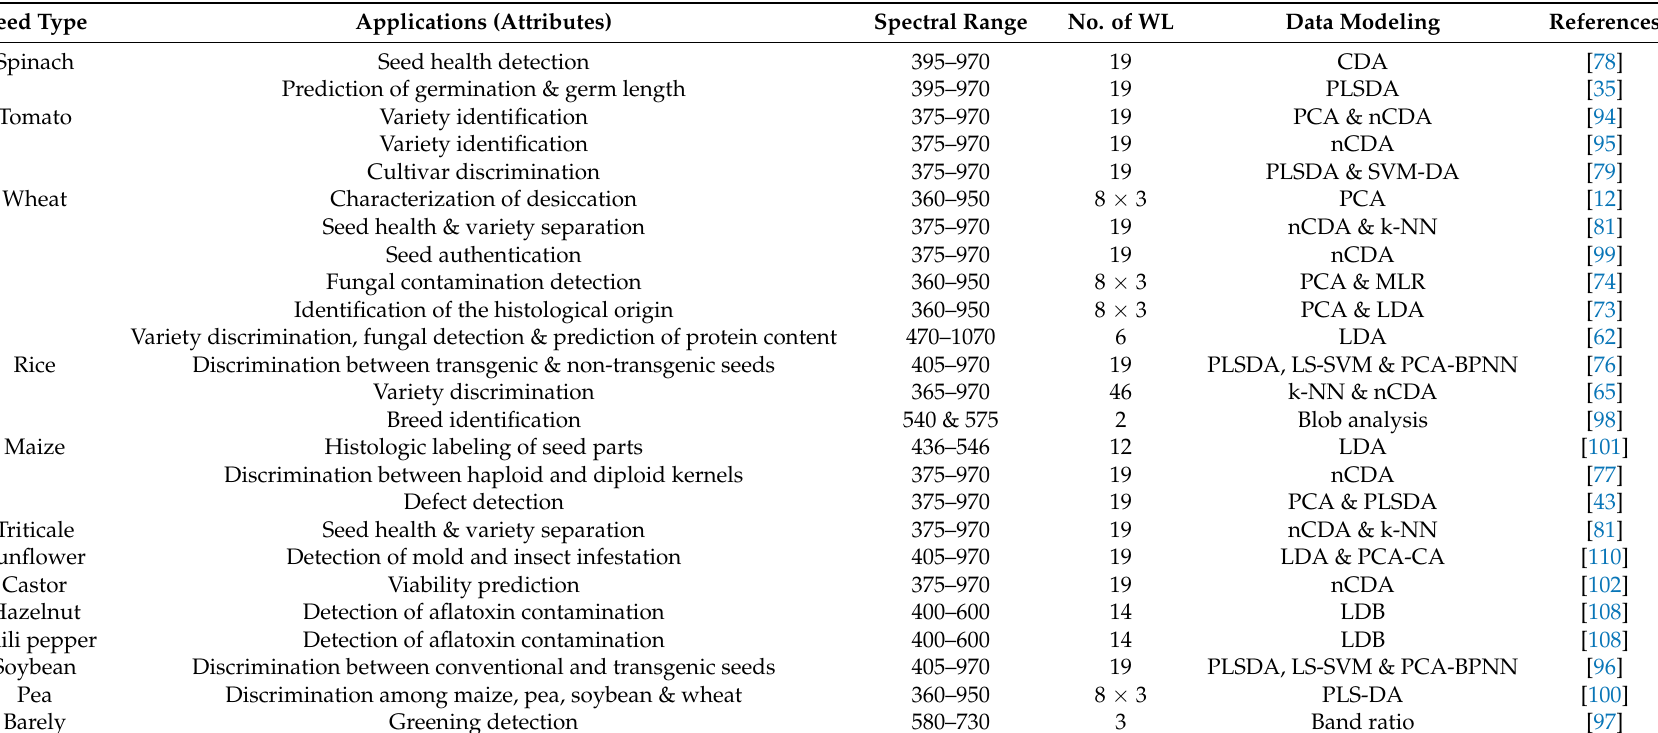
Table 1. Recent applications of multispectral imaging systems in phenotyping and quality evaluation of various